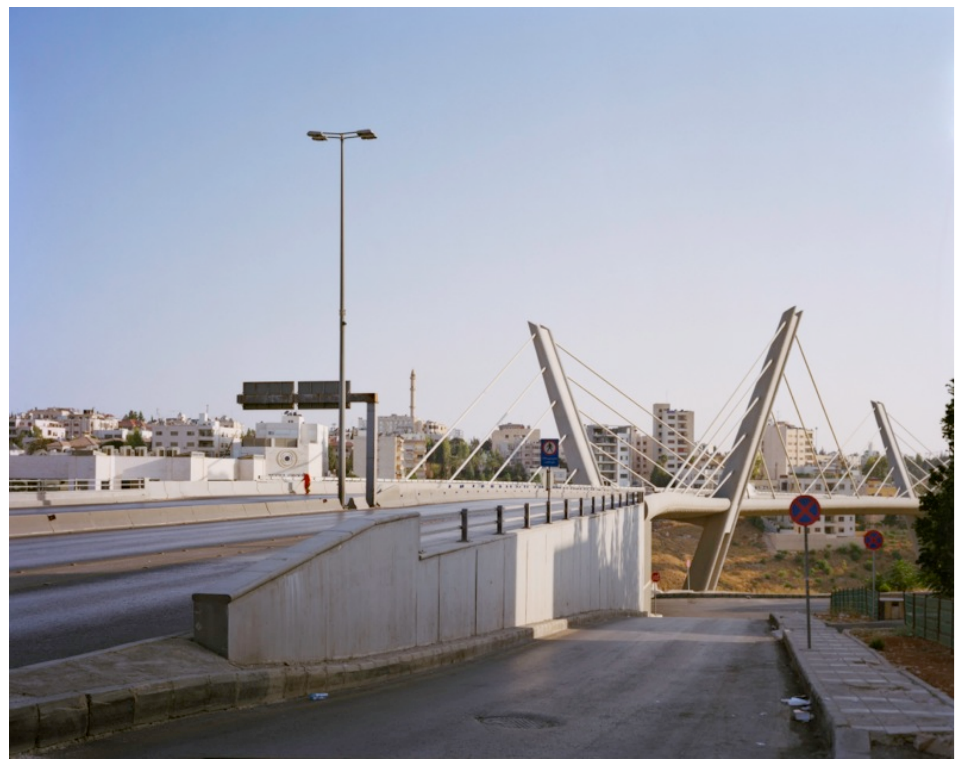
Regina Mamou, Untitled (Abdoun Bridge) from the series Mapping Collected Memory , 2009–2010. Digital C-print. 40 x 50 in. (101.60 x 127